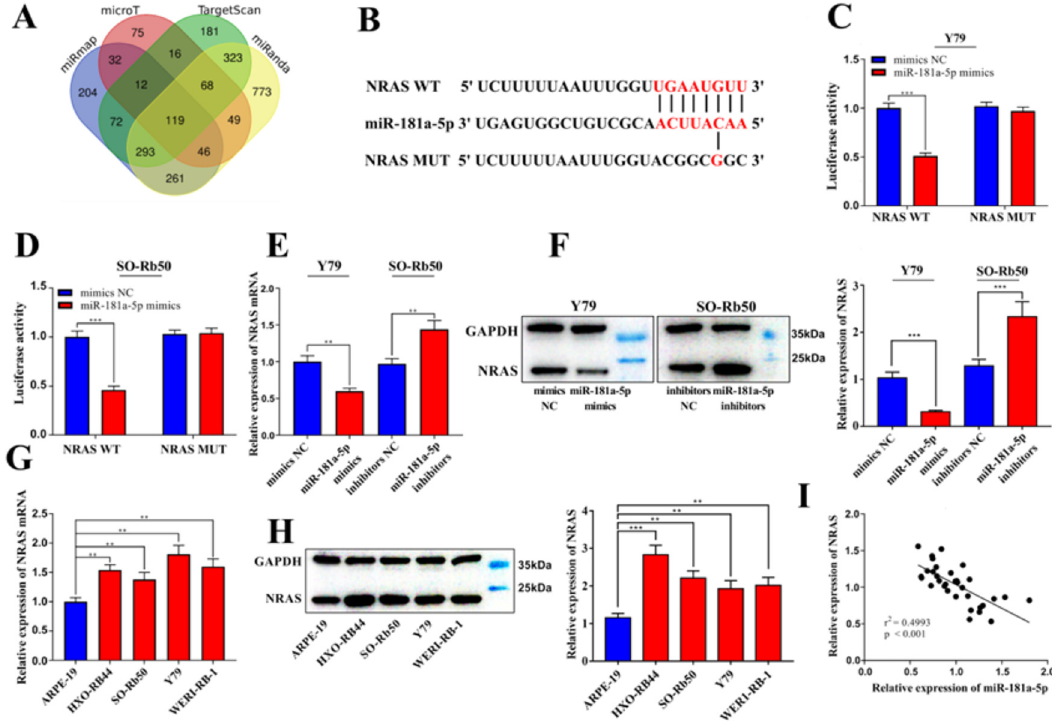
Fig. 4. NRAS is a target gene of miR-181a-5p. (A-B) TargetScan, miRanda, miRmap, and microT databases were used to predict the downstream target genes of miR- 181a-5p. (C-D) Dual-luciferase reporter gene assay veri fi ed that miR-181a-5p could combine with the 3 ′ -Untranslated Region (UTR) of NRAS. (E-F) qRT-PCR and west- ern blotting veri fi ed that the expression levels of NRAS mRNA and protein were downregulated in Y79 cells transfected with miR-181a-5p mimics and upregulated in SO-Rb50 cells transfected with miR-181a-5p inhibitors. (G-H) qRT-PCR and western blotting assays showed that the expression levels of NRAS mRNA and protein were signi fi cantly upregulated in RB cell lines compared to the ARPE-19 cells. (I) Correlation analysis showed that miR-181a-5p expression was negatively correlated with NRAS expression in RB tissues. Protein bands were quanti fi ed by comparison with the endogenous control, Glyceraldehyde 3-Phosphate Dehydrogenase (GAPDH). The data are shown as the mean ± standard deviation from three independent experiments. ** p < 0.01 and *** p <